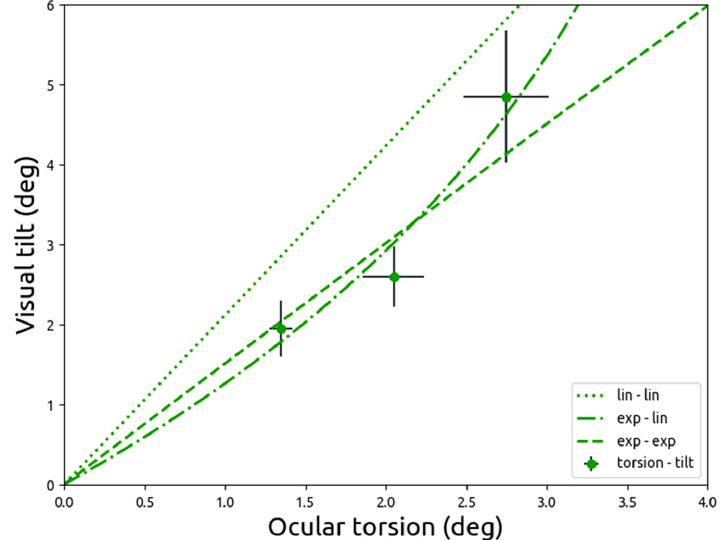
Figure 4. The relationship between the effects of galvanic vestibular stimulation on ocular torsion ( x -axis) and visual tilt ( y -axis). Points indicate averages of data reported by Zink et al. (1998) for galvanic vestibular stimulation unipolar direct current intensities 1.5, 2.0, and 3.0 mA, and error bars indicate the standard error of the mean. The dotted line (labelled ‘lin–lin’) is a combination of directly proportional linear models of the relationship between vestibular input and ocular torsion (Equation (3)) or visual tilt (Equation (4)). The dashed line (labelled ‘exp–exp’ is a combination of exponential models of the relationship between vestibular input and ocular torsion (Equation (5)) or visual tilt (Equation (6)). The dashed-dotted line (labelled ‘exp–lin’) represents a combination of Equations (5) and (4). The fits are the same as those presented in Figures 2 and 3; they are simply replotted in the same space.